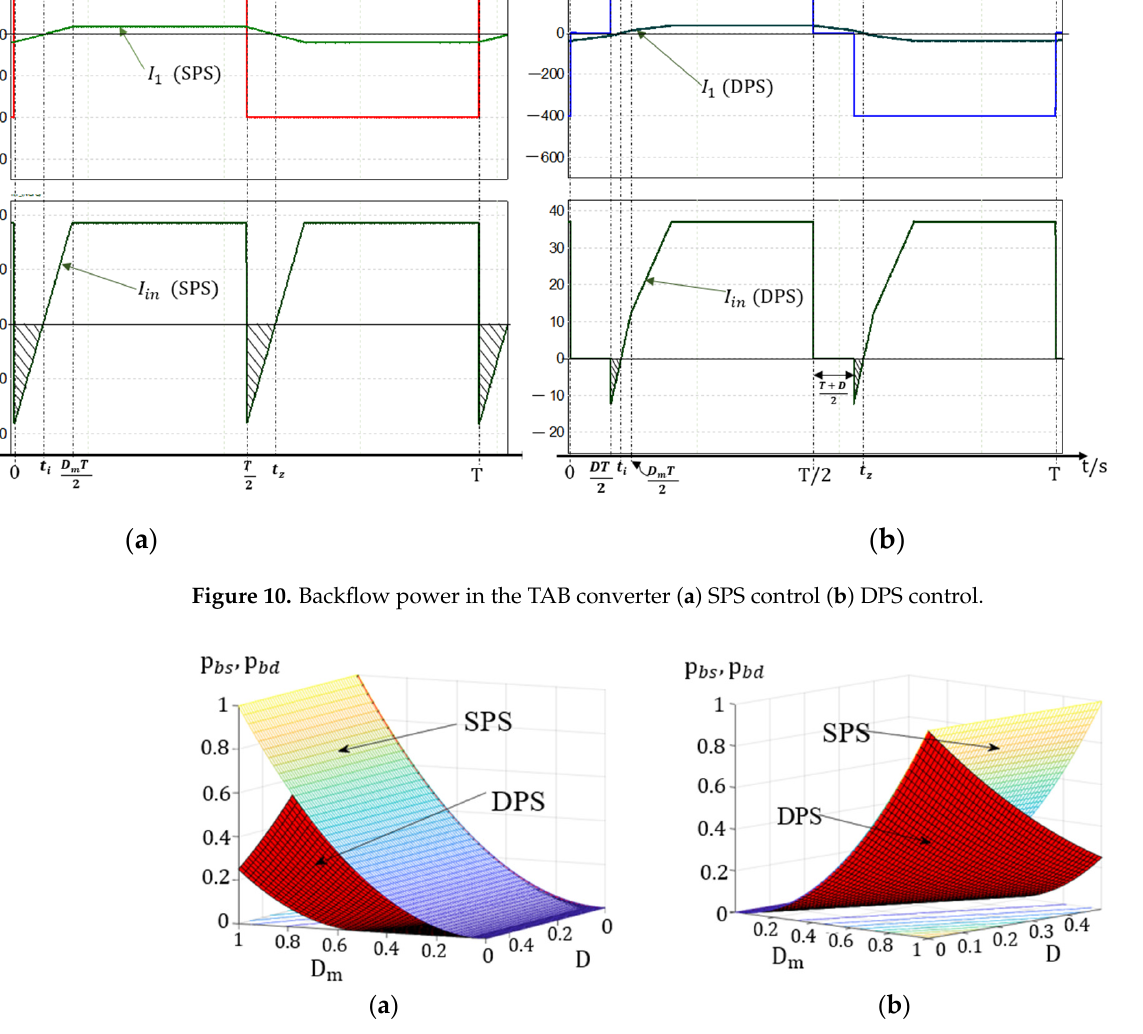
Figure 11. Unified backflow powers of the SPS and the DPS control ( a ) front and ( b ) rear view. Table 4 gives a summary of the comparison results. Table 4. Summary of comparison results.